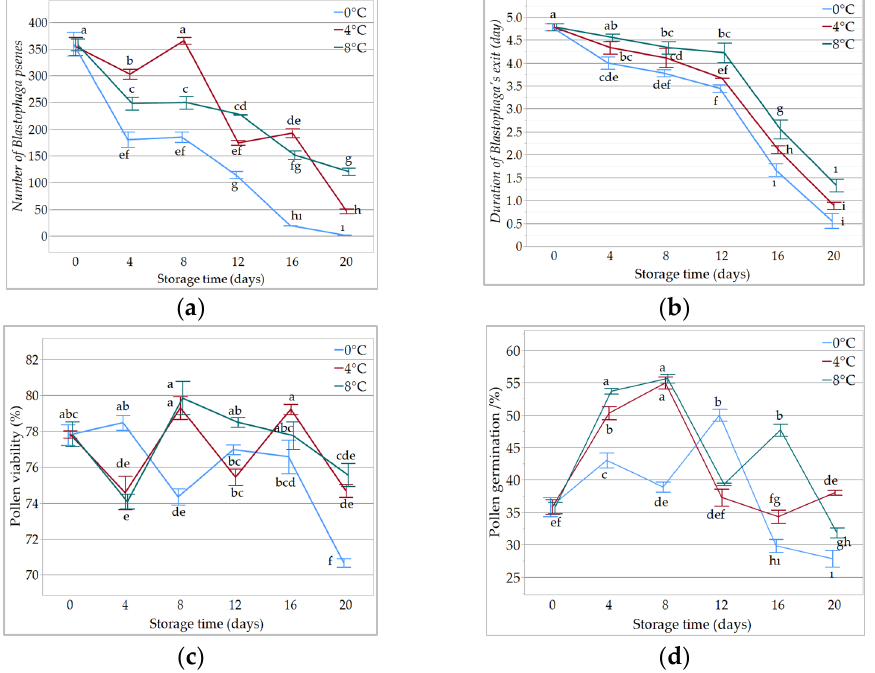
Figure 1. The effect of storage temperature and time interaction on ( a ) the number of B. psenes ; ( b ) duration of Blastophaga ’s exit; ( c ) pollen viability; ( d ) pollen germination . Different small letters indicate a significant difference according to Duncan test, p < 0.05.